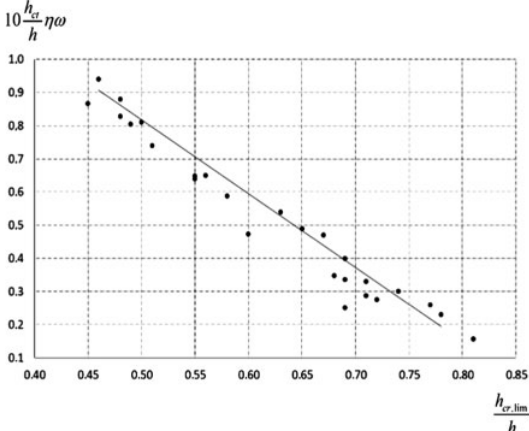
Fig. 6. Relationship between h cr,lim and h ct (the correlation coefficient 0.9616)